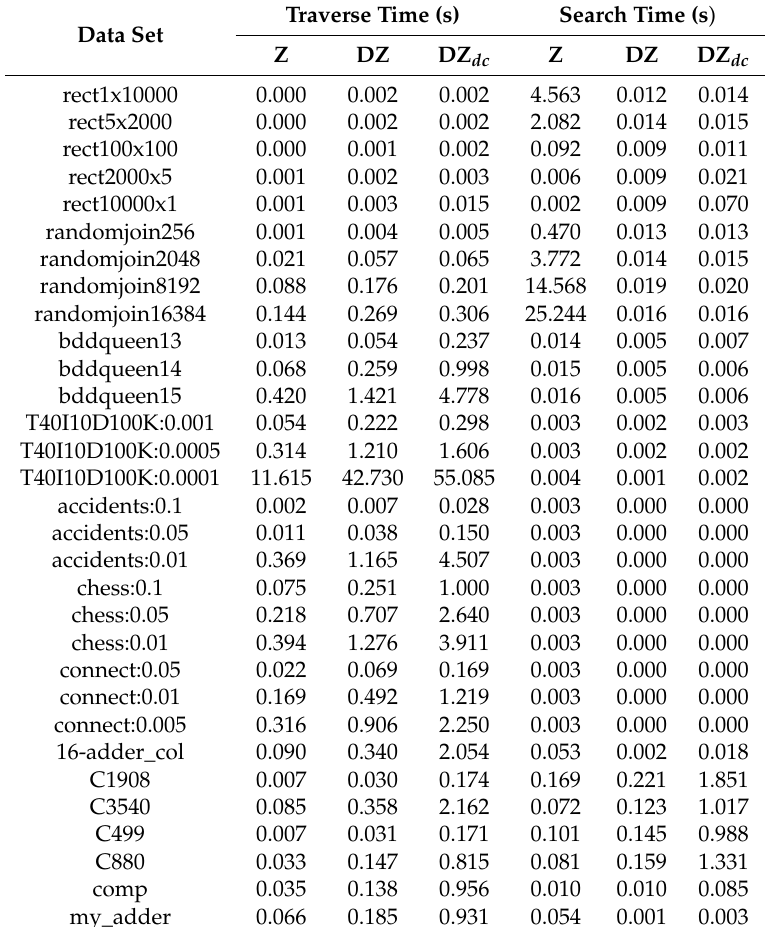
Table 5. DFS traversal time and random searching